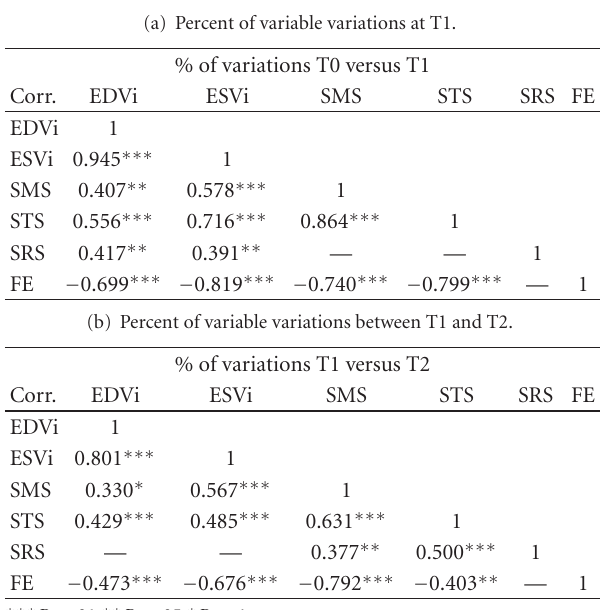
Table 3: Correlation matrix between percent of variation of the analysed variables. T0: time 0, T1: first step of followup, T2: second step of followup. EDVi: end diastolic volume index, ESVi: end systolic volume index, SMS: summed motion score, STS: